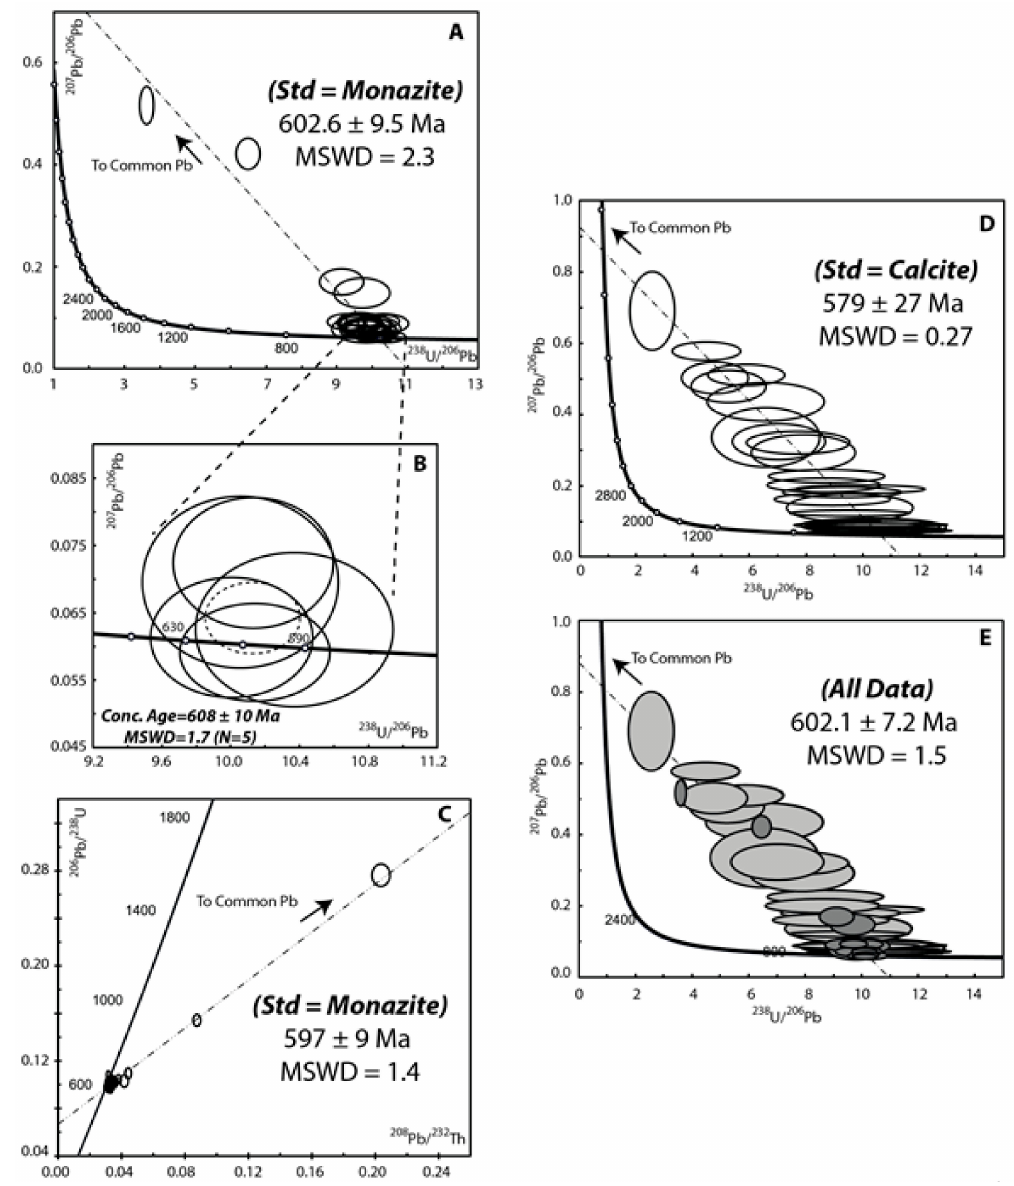
Figure 14. Tera–Wasserburg and 206 Pb/ 238 U versus 208 Pb/ 232 Th Concordia diagrams for bastnaesite crystals from Gakara. Error ellipses and age calculations are reported with 2 σ errors. ( A ) Tera–Wasserburg diagram with all the data obtained by standardizing bastnaesite with a monazite standard. ( B ) Zoom of Figure 14A with concordant data only. ( C ) 206 Pb/ 238 U versus 208 Pb/ 232 Th diagram for the bastnaesite standardized with a monazite standard. ( D ) Tera–Wasserburg diagram with all the data obtained by standardizing bastnaesite with a calcite standard. ( E ) Tera–Wasserburg diagram combining all the data acquired on